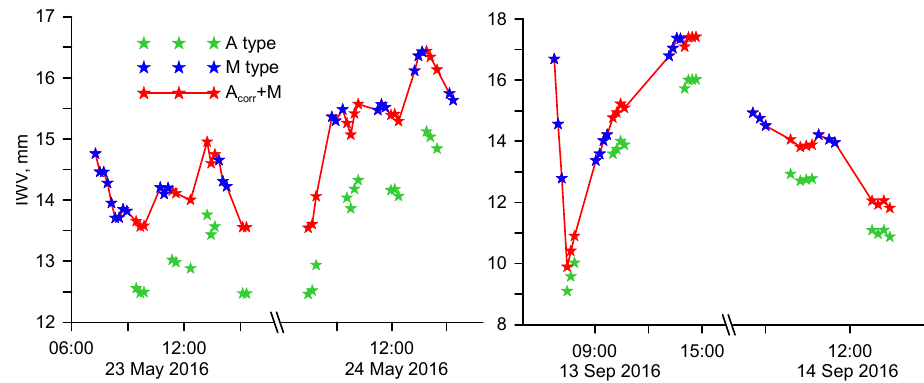
Figure 6. Diurnal variations of IWV content observed by the FTIR technique: the A-type retrieval (green stars), the M-type retrieval (blue stars), and the joint A corr and M-type retrieval (red line with stars).